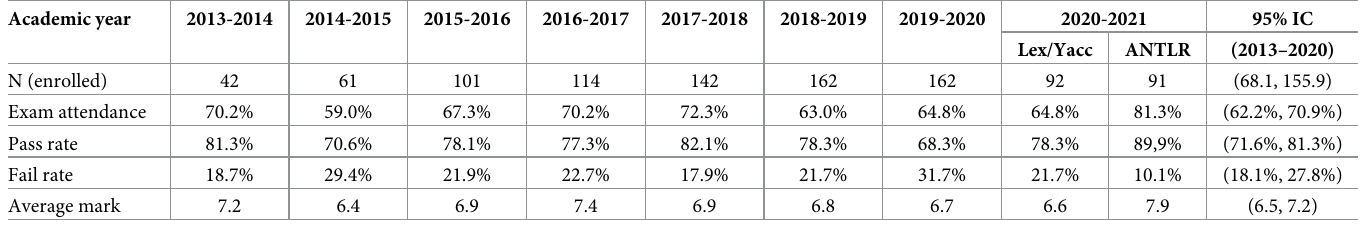
Table 8. Evaluation rates in the last 8 academic years for the Programming Language Design and Implementation